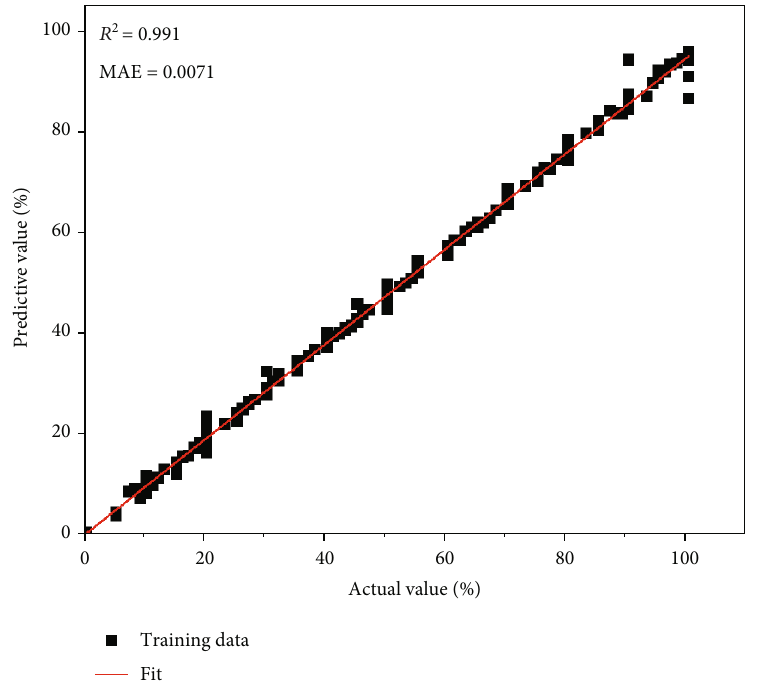
Figure 14: Model output and actual data: training data